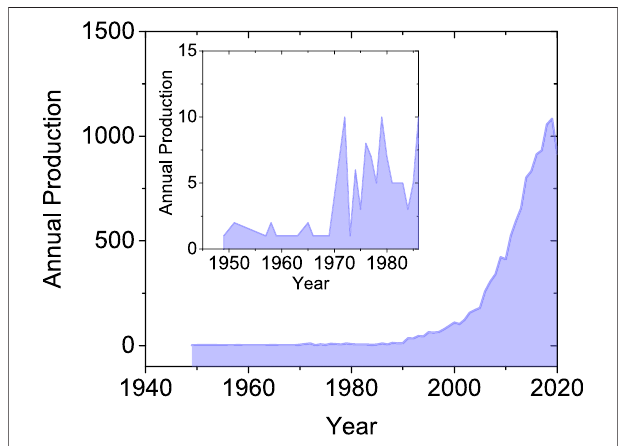
FIGURE 1 | Bibliographic annual production. Annual number of articles produced in the topic of microgels and nanogels, from the fi rst paper in 1949 de fi ning the term microgel until 2020. The inset represents the annual production from 1949 to 1986.